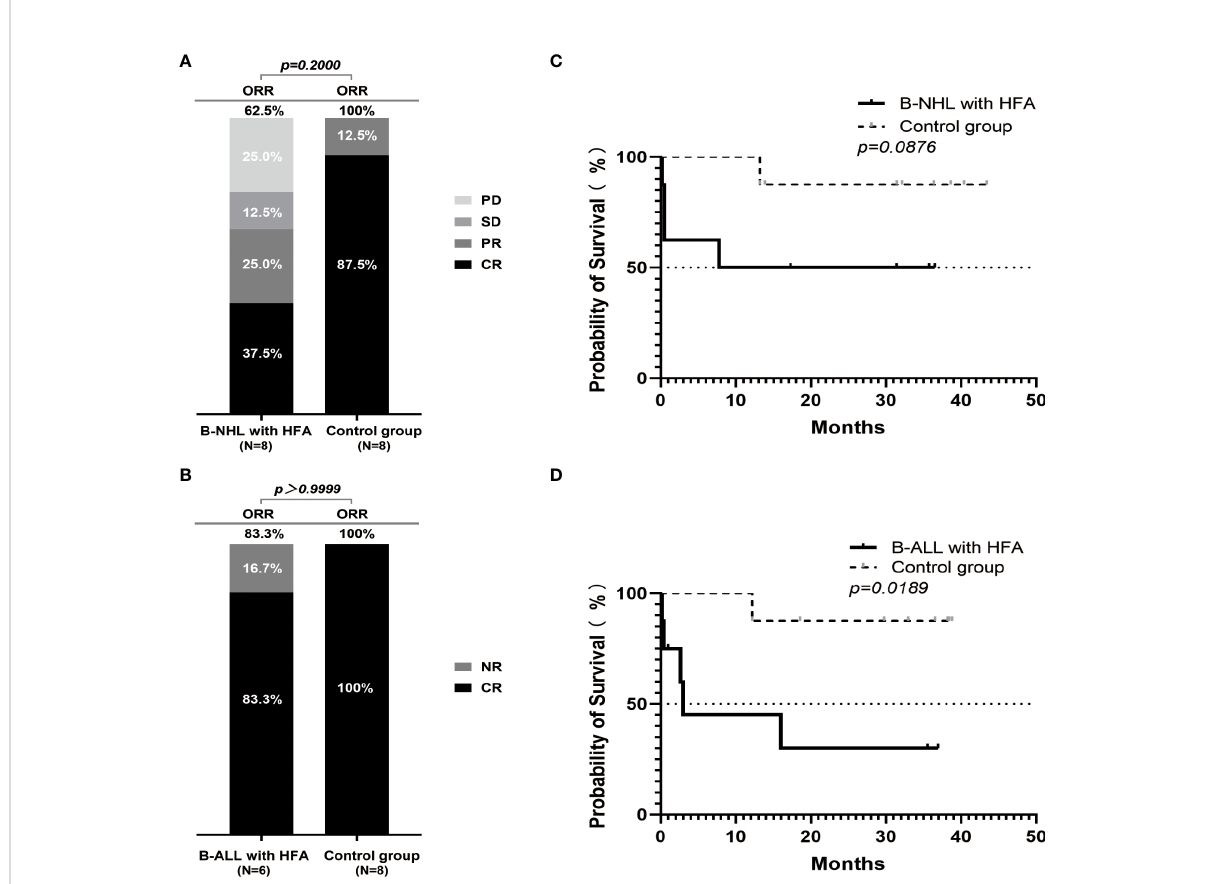
FIGURE 1 Outcomes of r/r B-NHL and r/r B-ALL cases according to hyperferritinaemia status after the CAR19/22 T-cell therapy. The percentage of patients with CR, PR, SD, PD or CR, NR as the best response in 16 patients with r/r B-NHL (8 in HFA group and 8 in control group) (A) and 14 evaluable patients with r/r B-ALL (6 in HFA group and 8 in control group) (B) . Overall survival in the B-NHL (C) and B-ALL (D) cohorts on the basis of hyperferritinaemia status (each cohort included 8 patients with HFA and 8 control